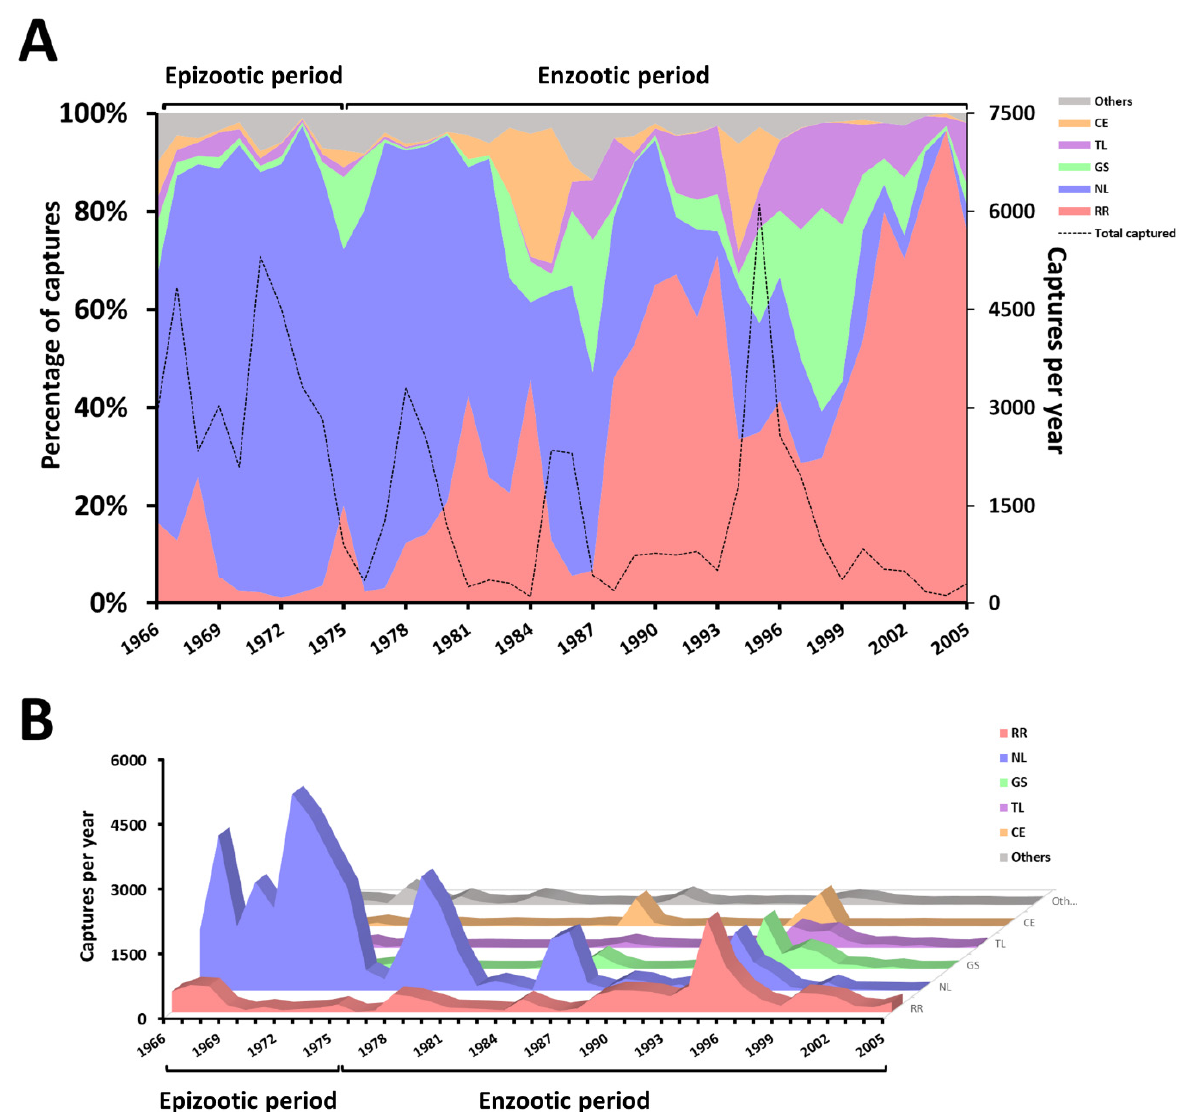
Figure 2. Abundance of rodents captured in Exu, Pernambuco, Brazil, 1966 to 2005. ( A ) The left axis displays the fluctuations in the proportion of captured rodent species as percentages, while the right axis shows the total number of captured animals per year. ( B ) The absolute number of captured animals per year according to the species.